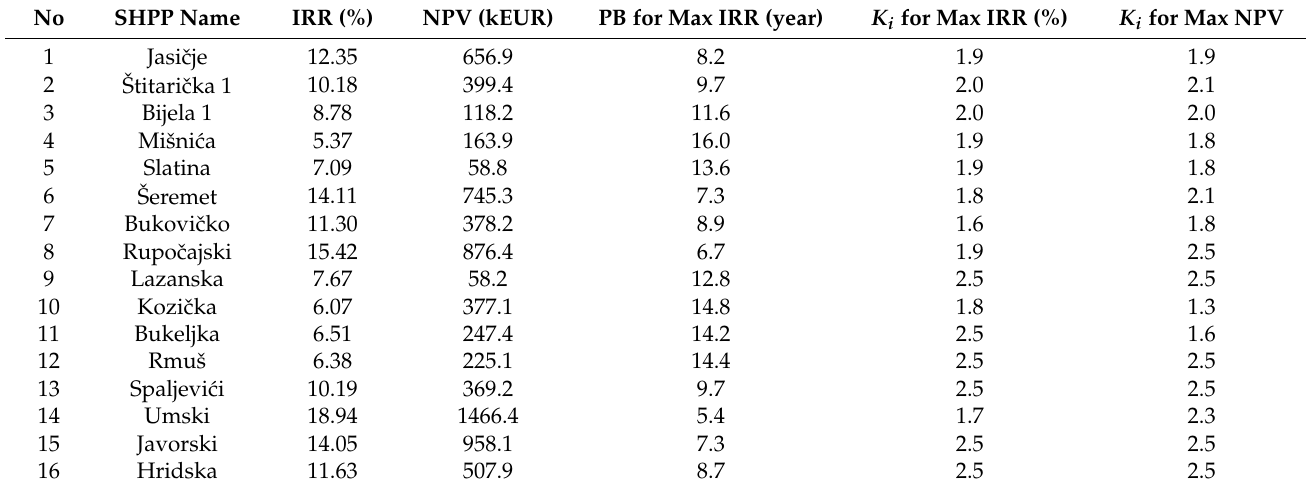
Table 4. Internal rate of return, net present value, payback period, and corresponding SHPP installed parameter for SHPPs below 1 MW—Group